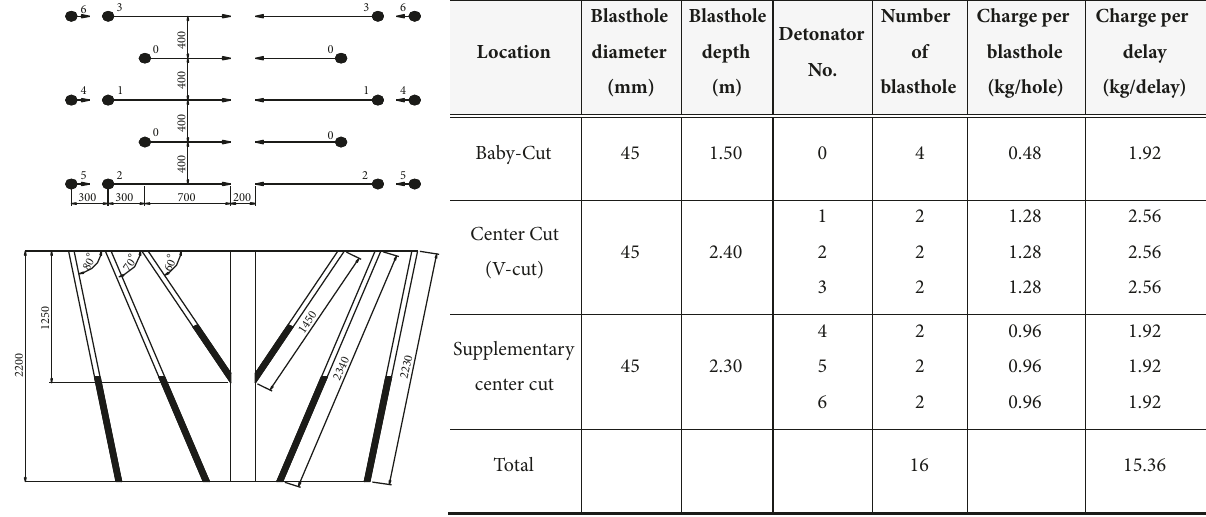
Figure 7: Blasting pattern (V-cut) (Test